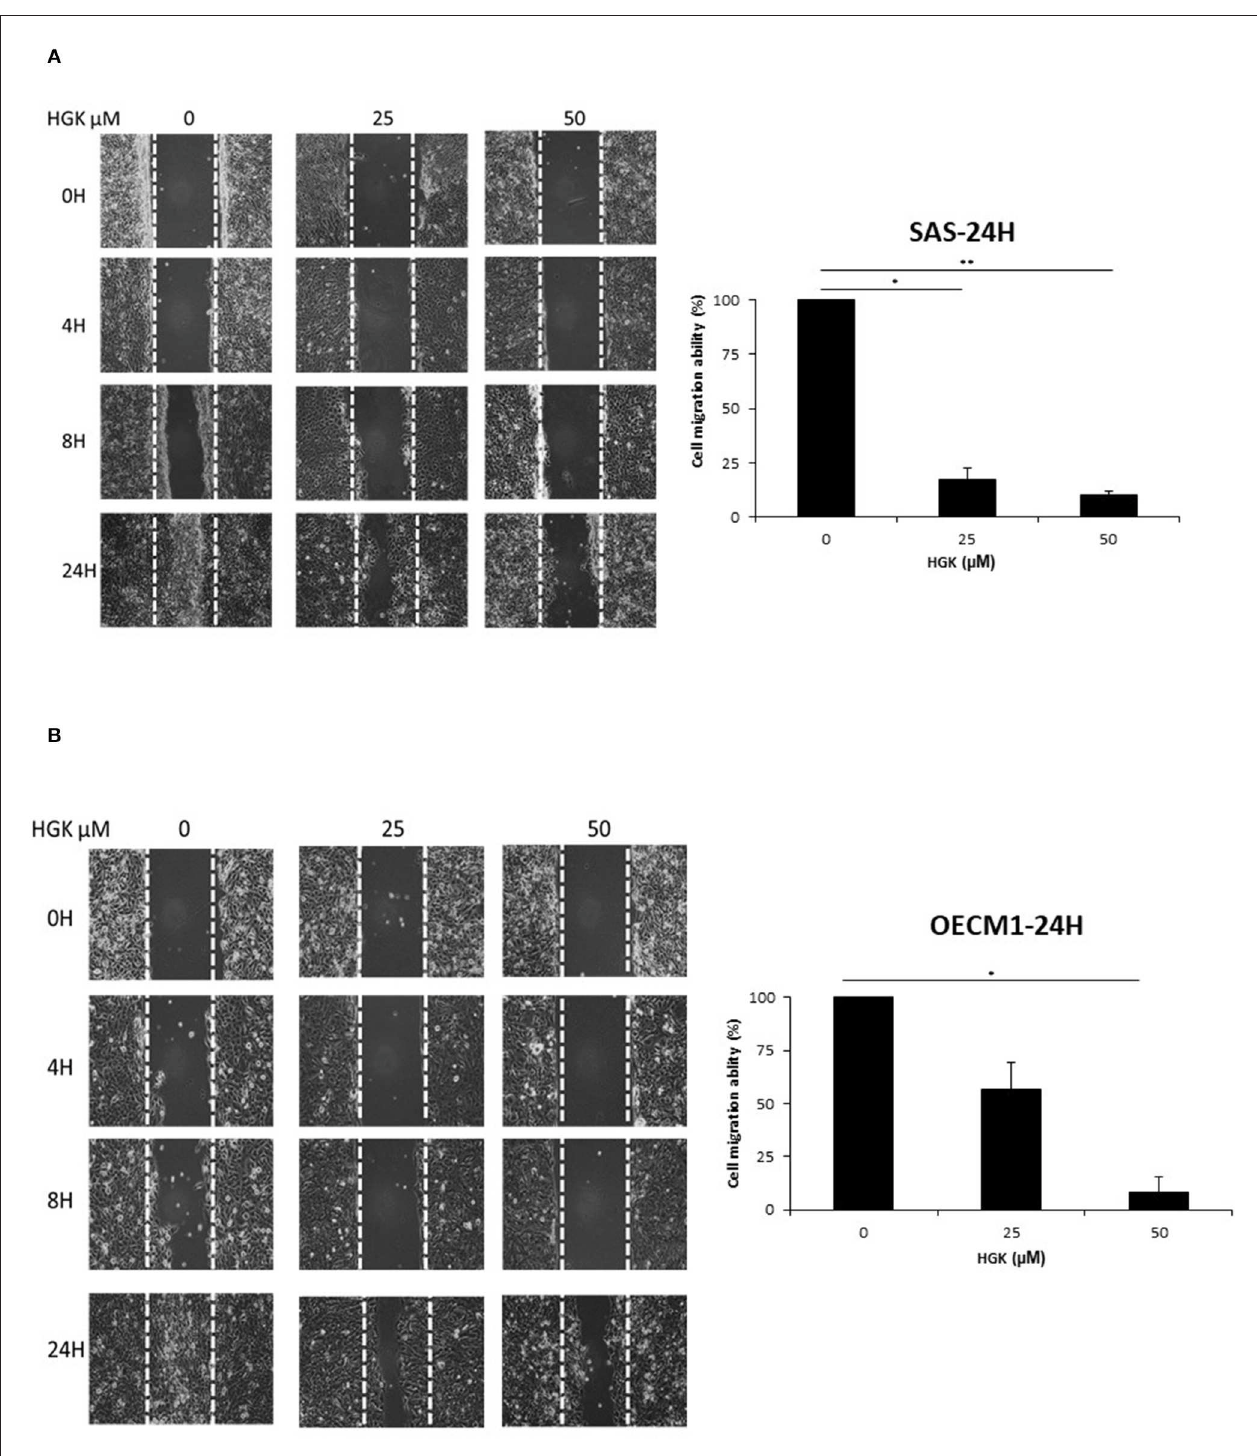
FIGURE 5 | Effects of HGK on cell migration in SAS (A) and OECM1 (B) cells. SAS and OECM1 cells were treated with 0, 25, 50, 75 µ M HGK for 24h. The results are shown as the mean ± S.E. of three independent experiments. * P < 0.05 and ** P < 0.01.